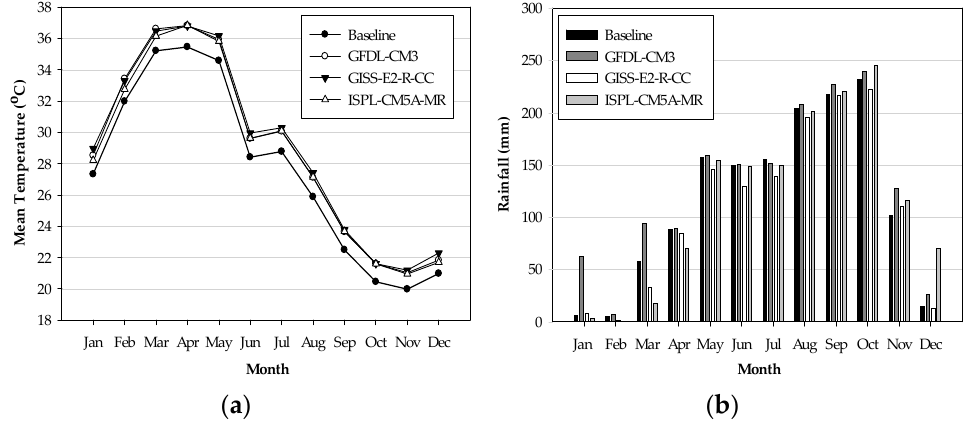
Figure 2. ( a ) Mean monthly temperatures and ( b ) mean monthly precipitation for baseline (1982–2010) and future (2051–2070) period.